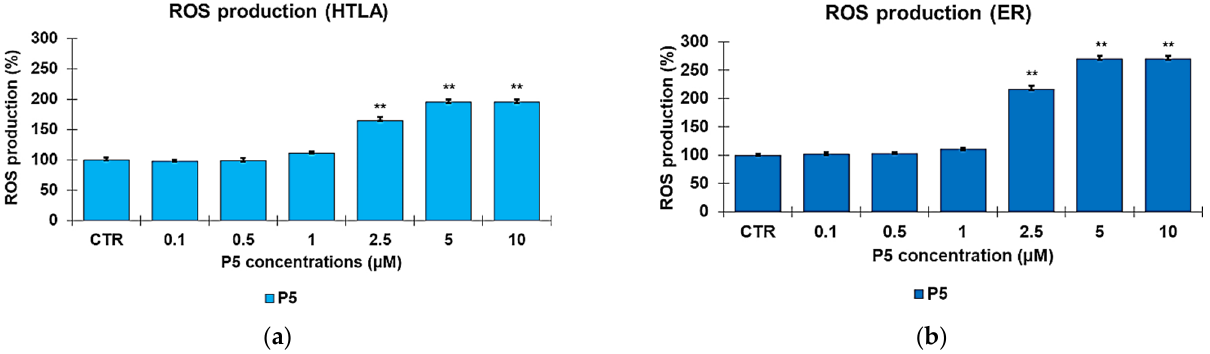
Figure 9. Reactive oxygen species (ROS) generation was analyzed in HTLA-230 (HTLA, a ) and HTLA-ER (ER, b ) cells